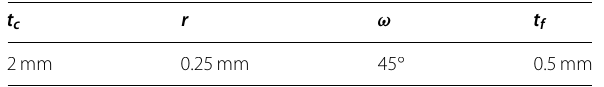
Table 1 Nominal parameters of the considered AM sandwich structures